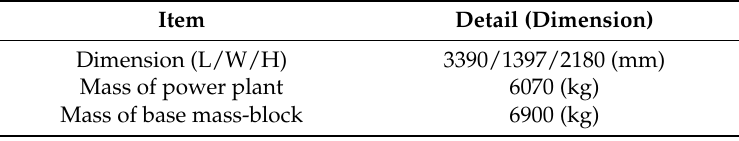
Table 1. Specification of electric power plant.